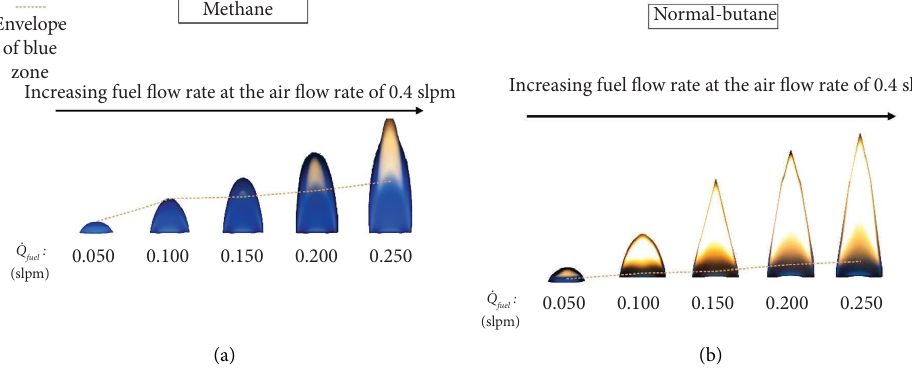
Figure 9: Te efects of the fuel fow rate increase on the fame appearance and structure for (a) methane and (b) n-butane.